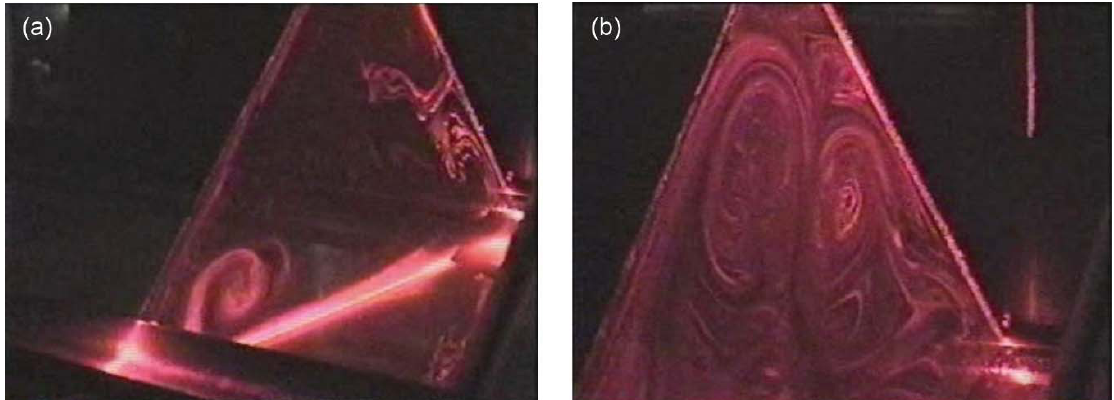
Figure 9. Visualization experiments of the convection flows in a cavity similar to those used in solar distillation. Natural convection begins ( a ) and steady ‐ state convection ( b ).